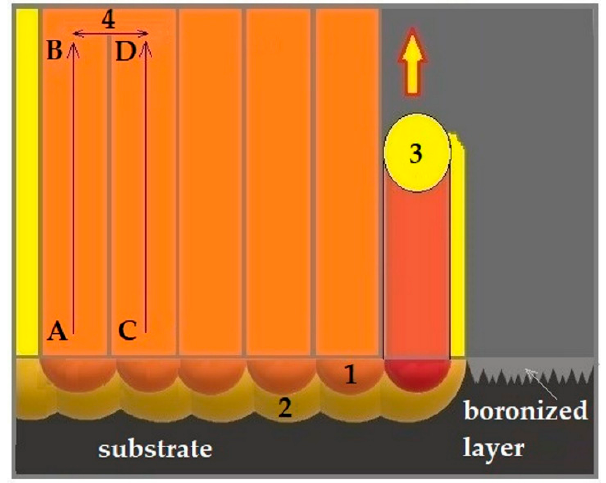
Figure 1. Scheme of the laser processing of a diffusion boronized layer: 1—melted zone (MZ), 2—heat-affected zone (HAZ), 3—laser beam, 4—tracks overlapping.